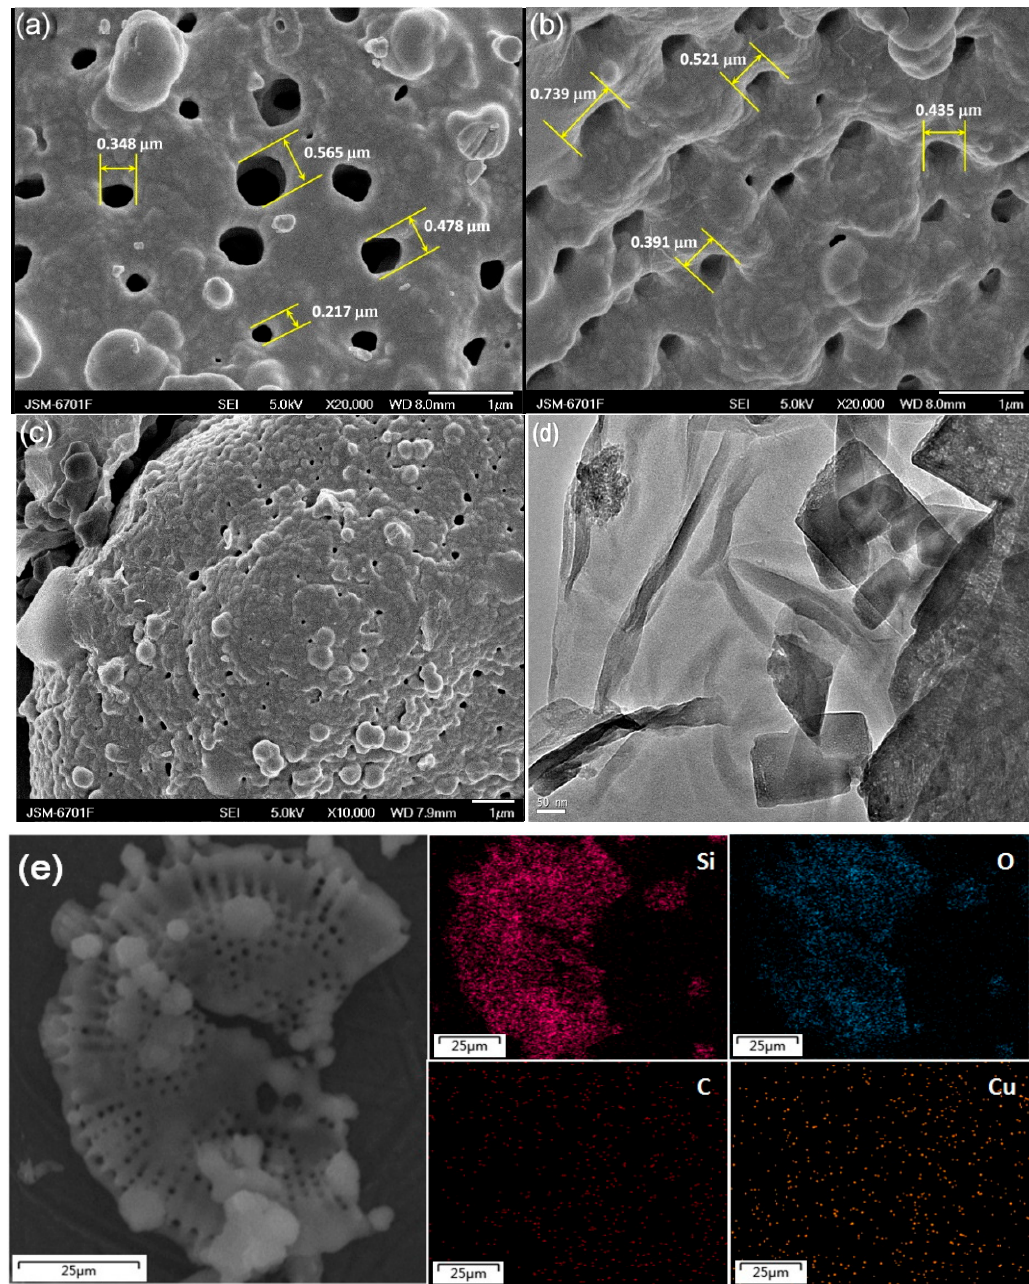
Figure 2. SEM micrographs of ( a ) DE, ( b ) GO-DE, and ( c ) CuO/GO-DE; ( d ) TEM micrograph of CuO/GO-DE; ( e ) EDS mapping images of CuO/GO-DE CuO/GO-DE; ( e ) EDS mapping images of CuO/GO-DE composites.